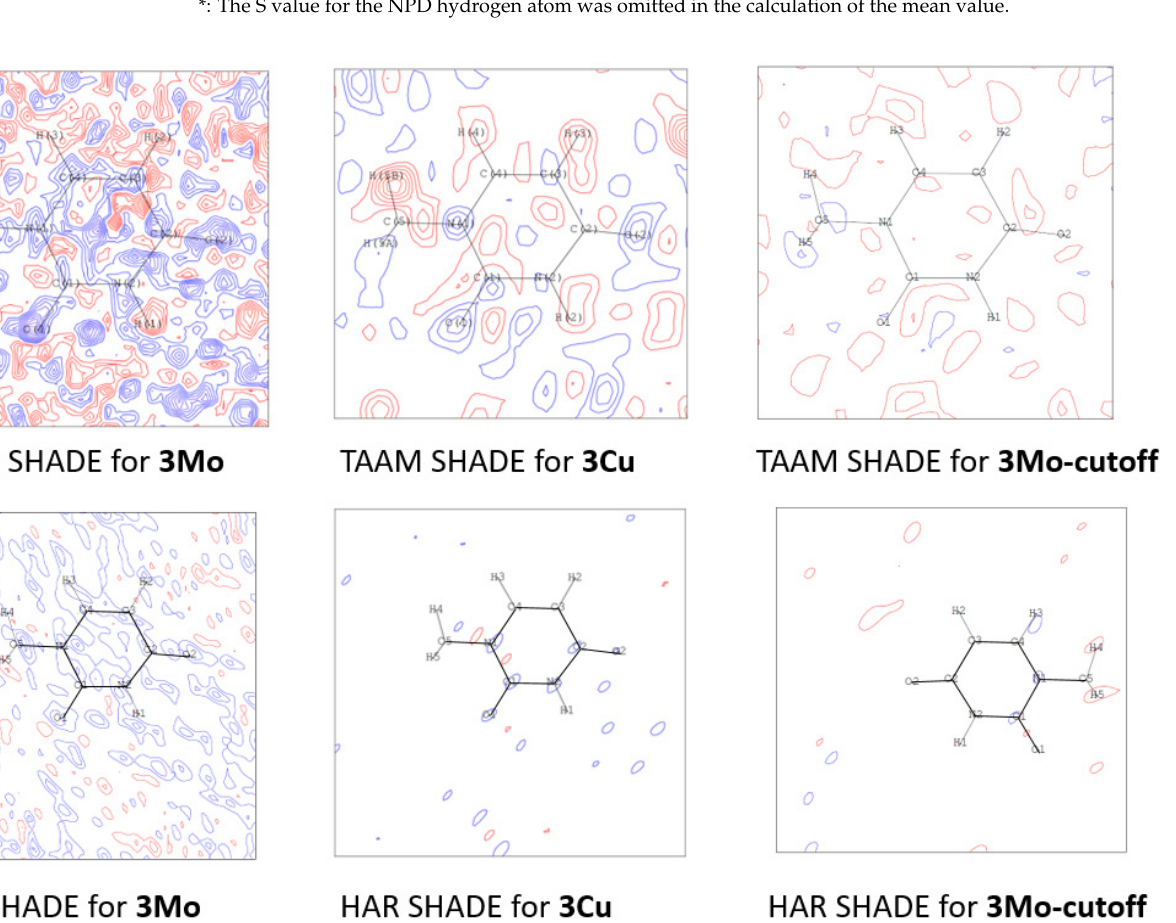
Figure 9. Residual density maps for HAR_SHADE and TAAM_SHADE refinements of 3Mo , 3Cu , and 3-cutoff . Maps are presented with contour levels with intervals of ± 0.05 eÅ − 3 . All residual density maps for the analysed compounds are available in the Supplementary Materials (Figures S2–S4).